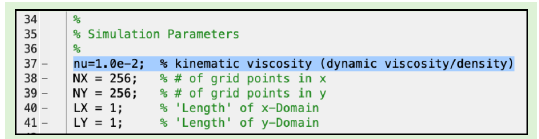
Figure 8. Changing the kinematic viscosity, ν , to a different